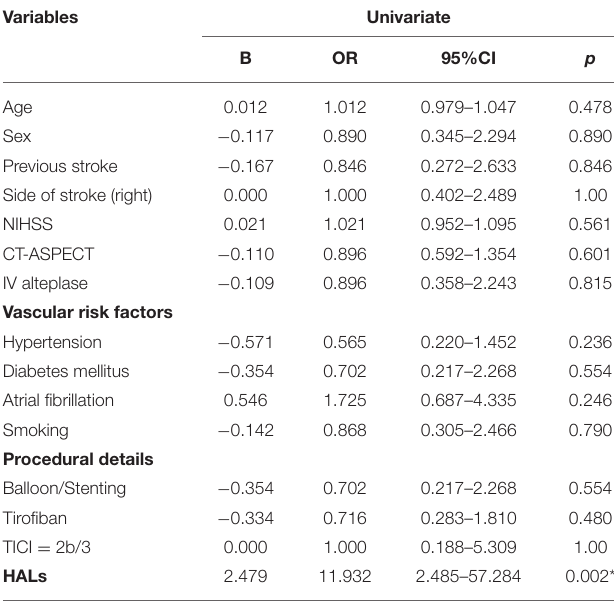
TABLE 2 | Univariate logistic regression for predicting IH after propensity score matched.